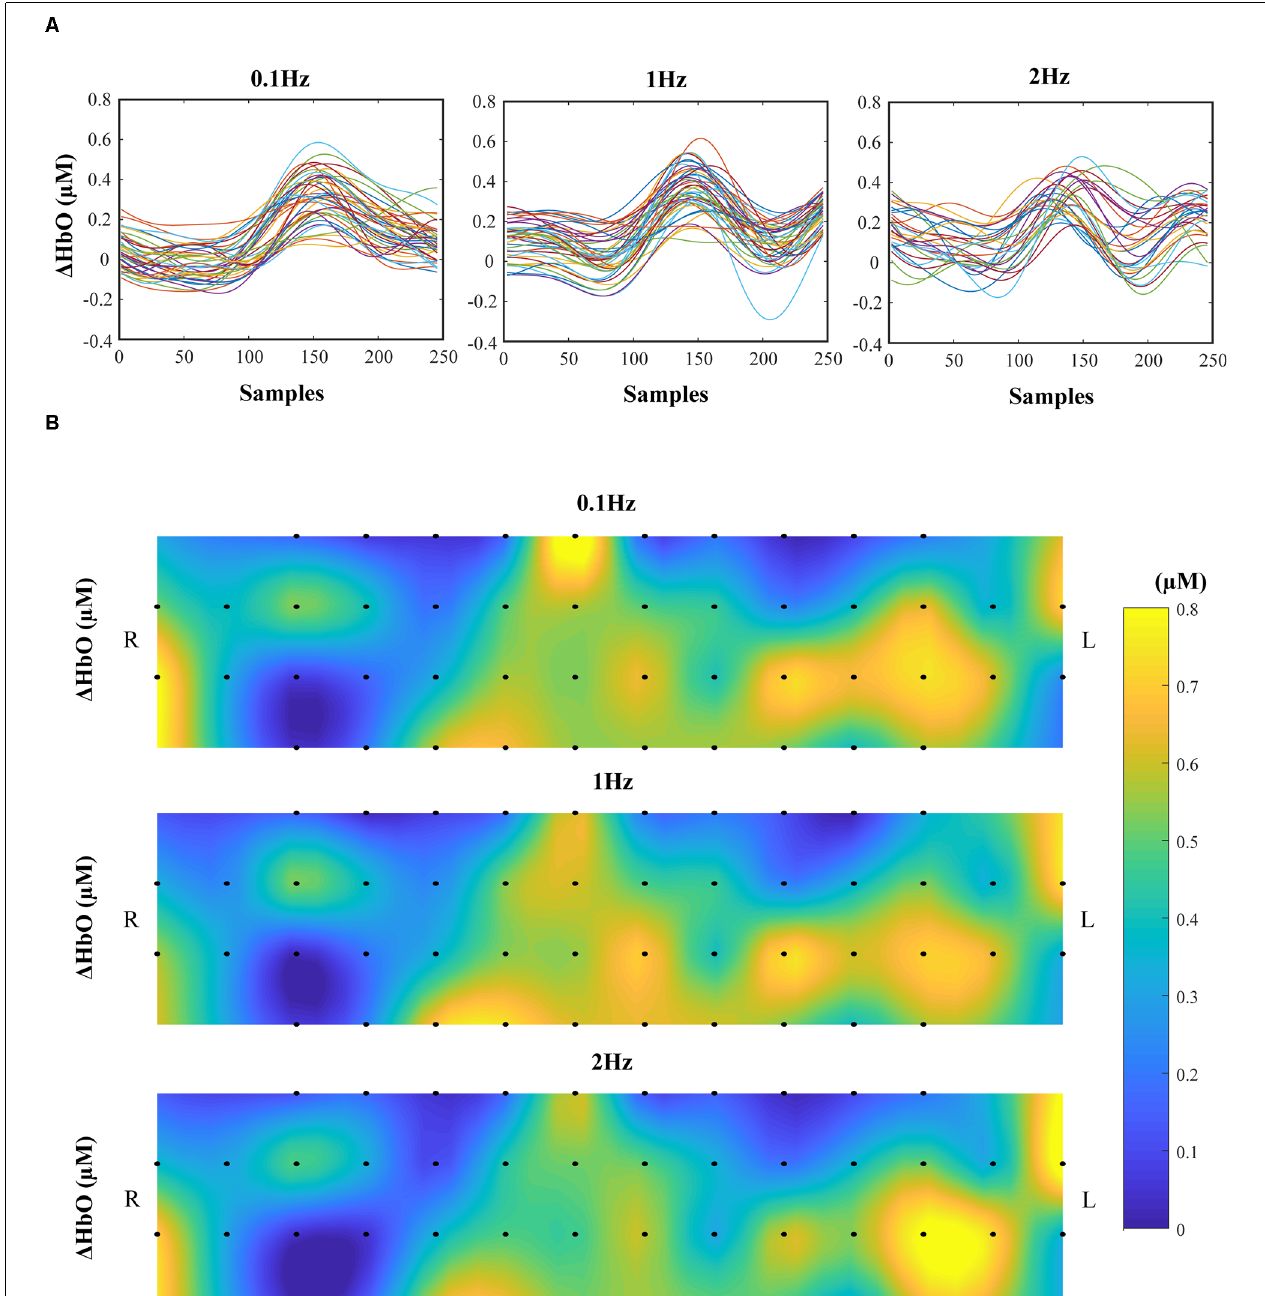
FIGURE 6 | The concentration changes in oxy-hemoglobin ( ∆ HbO). The time profiles of ∆ HbO of all 48 channels are presented in 0.1 Hz ( left panel ), 1 Hz ( middle panel ), and 2 Hz ( right panel ). The data are from a representative participant (A) . Average ∆ HbOs across time samples and participants for 48 channels were presented. The top panels show the average ∆ HbO for 0.1 Hz, the middle panels for 1 Hz, and the bottom panels for 2 Hz condition. The color bar encodes the strength of ∆ HbO, and the bar length corresponds to the ∆ HbO values between 0 µ M and 0.8 µ M (B)